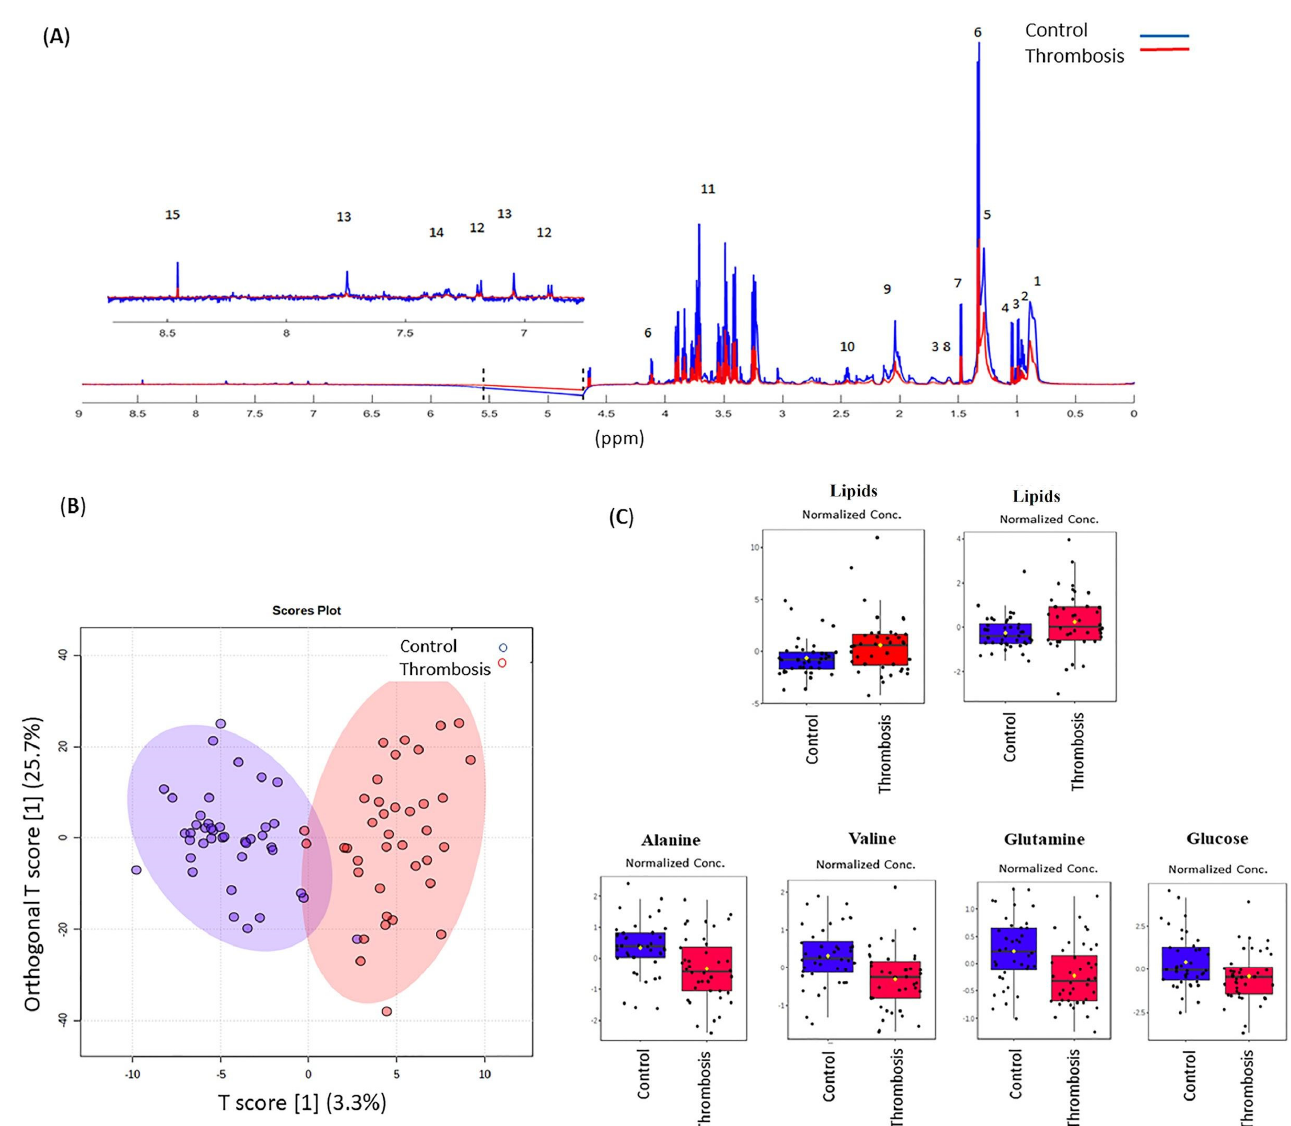
Figure 1. ( A ) 1 H-NMR CPMG spectra illustrating differences between thrombosis and control group. The identified metabolites were: 1. Fatty acyl chain terminal methyl group hydrogens -CH 3 ; 2. Isoleucine; 3. Leucine; 4. Valine; 5. Lipids CH 3 (CH 2 )n; 6. Lactate; 7. Alanine; 8. Fatty acyl chain hydrogens from the -CH 2 - group next to the carboxyl group, as in CH 2 CH 2 C(O); 9. Fatty acyl chain CH 2 CH=; 10. Glutamine; 11. Multiple glucose hydrogens; 12. Tyrosine; 13. Histidine; 14. Phenylalanine; 15. Formate. The HDO ( δ 4.70–5.50) regions were removed before the analyses, indicated with the dotted lines. The inset shows the expanded ( δ 6.50–8.50) spectral regions; ( B ) Multivariate OPLS-DA; ( C ) Relative metabolite levels (measured as peak intensities) by VIP score. The black dots represent the metabolite levels in all samples, and the yellow diamond represents the average value. Patients (Thrombosis) are illustrated in red, and controls in blue.